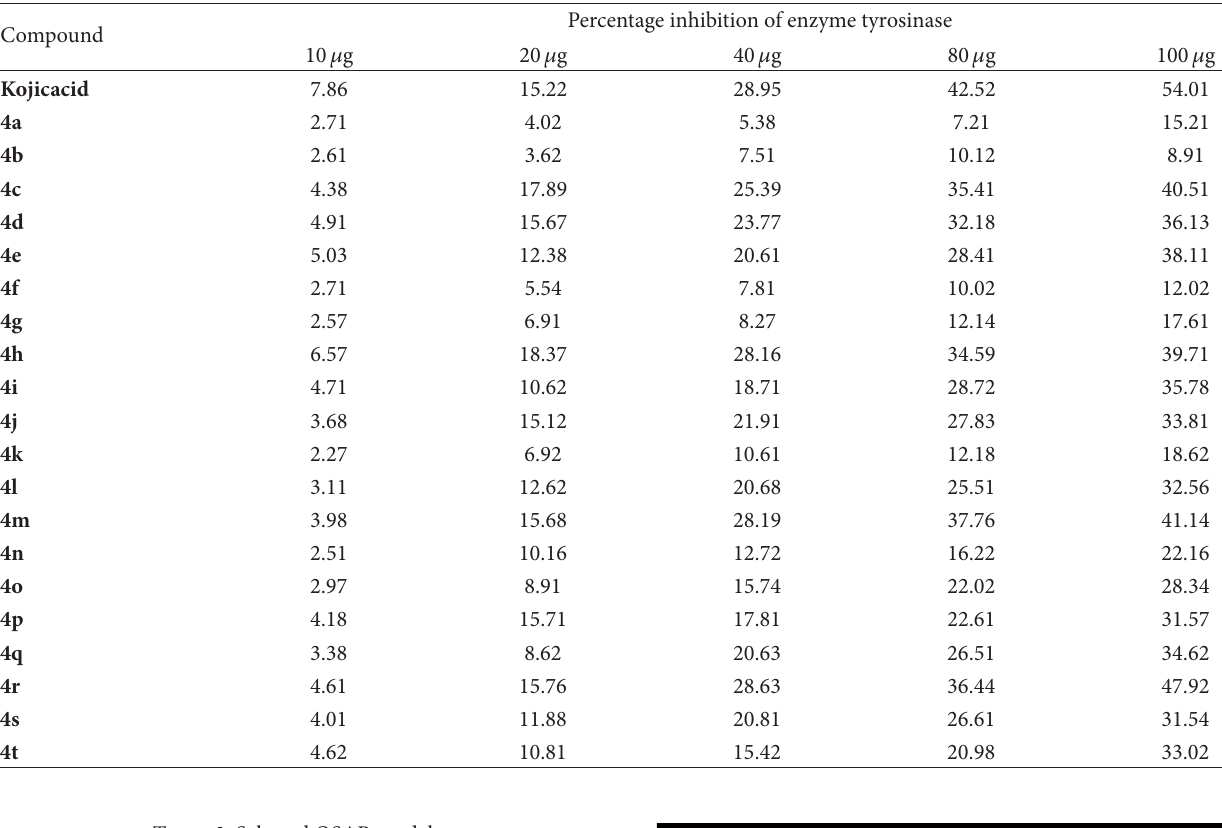
T 2: Tyrosinase inhibition activity of title compounds.